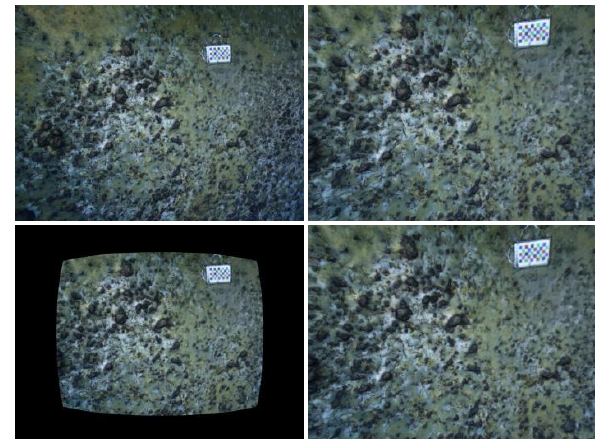
Figure 7. Rendered ground truth image (top left), rendered refracted image (top right), refraction corrected image (bottom left), converted image from refraction corrected image frame to original input image frame (bottom right). Please note that the bottom right color image is not needed during the workflow, only the converted depth map under the same image frame is used.